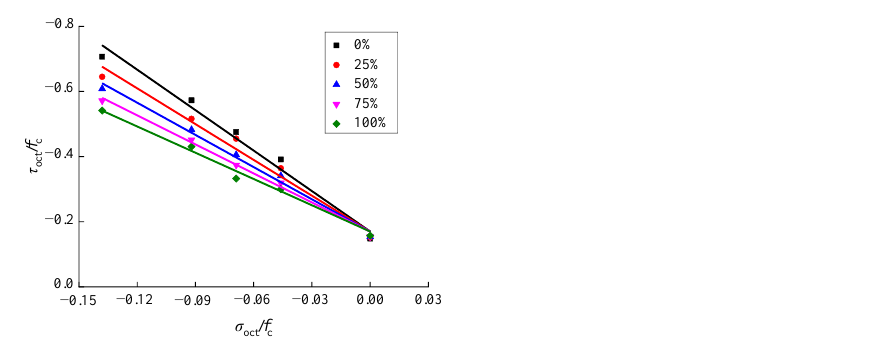
Figure 13. Compression – shear octahedral stress spatial relationship of recycled concrete.